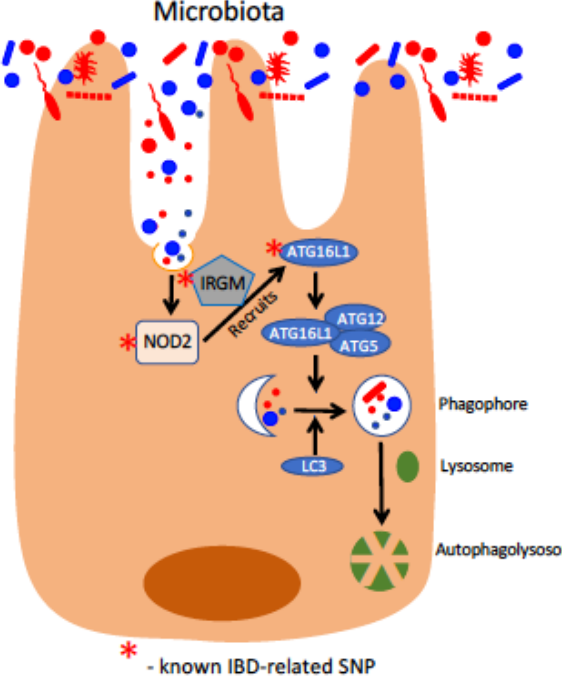
Figure 1. Defects in epithelial xenophagy responses in IBD. Shown here is the xenophagic re- sponse to luminal microbes and microbial components. These components are recognized by NOD2, which, in conjunction with IRGM, recruits components of the autophagic machinery, including ATG16L1. Upon activation, ATG16L1 associates with the ATG5-ATG12 complex to recruit LC3 in the development of the membrane enclosed phagophore. The cargo-loaded phagophore fuses with cellular lysosomes to form the autophagolysosome in the final degradation and recycling of the xenophagic cargo. Components of this pathway with known IBD-related SNPs are designated with a red asterisk.